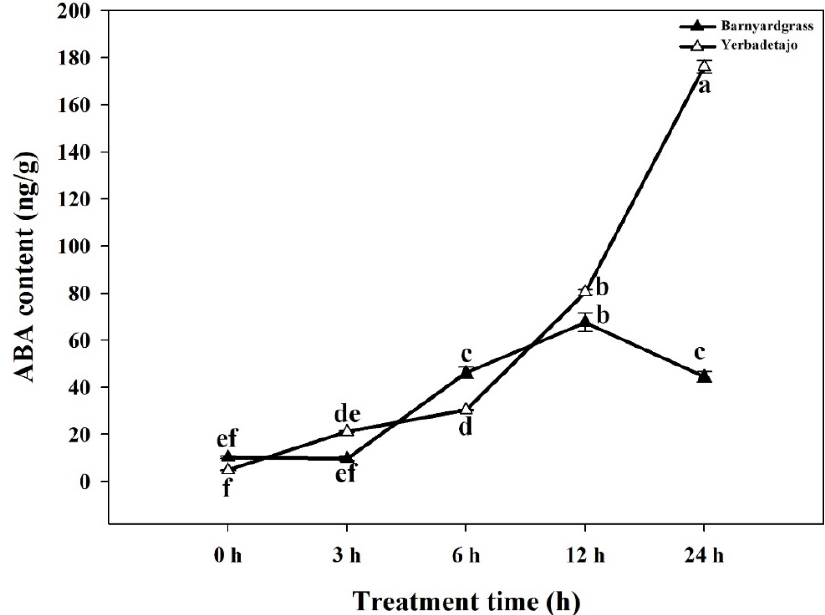
Figure 3. ABA content in barnyardgrass and yerbadetajo after florpyrauxifen-benzyl treatment. The X -axis represents the treatment time; the Y -axis represents ABA content. a–f represents the significance level ( p < 0.05) (the significance mark of barnyardgrass is above the broken line, and the significance mark of yerbadetajo is below the broken line). Vertical bars represent standard errors of the means.